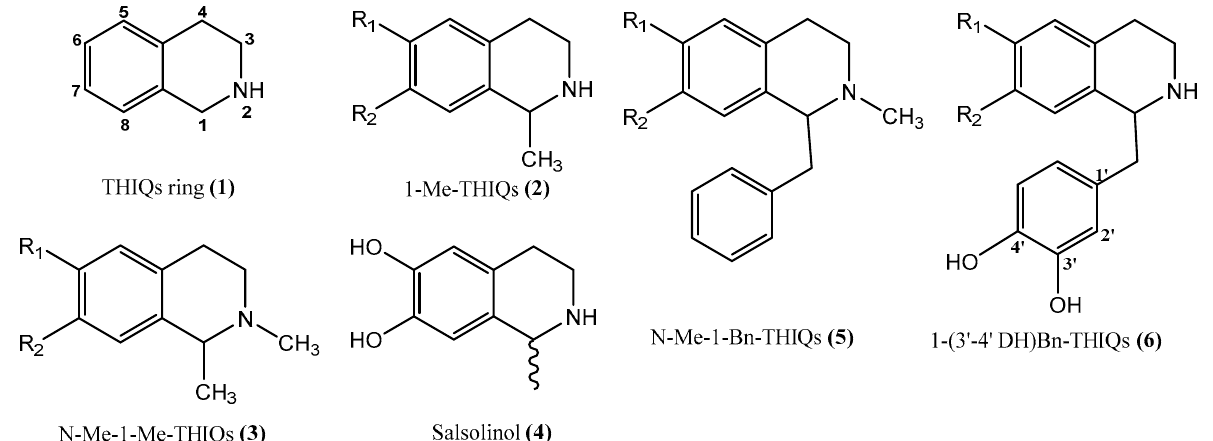
Figure 2. Tetrahydroisoquinolines ring and some derivatives, ( 1 ) Tetrahydroisoquinolines ring ( 2 ) 1-methyl-1, 2, 3, 4-tetrahydroisoquinolines, ( 3 ) 1- methyl-2-methyl-1,2,3,4-tetrahydroisoquinolines, ( 4 ) salsolinol (1-methyl-6,7-dihydroxy-1,2,3,4-tetrahydroisoquinoline), ( 5 ) 1-benzyl-1, 2, 3, 4- tetrahydroisoquinolines, ( 6 ) 1-(3 ′ -4 ′ dihydroxy)-benzyl-1,2,3,4-tetrahydroisoquinolines.